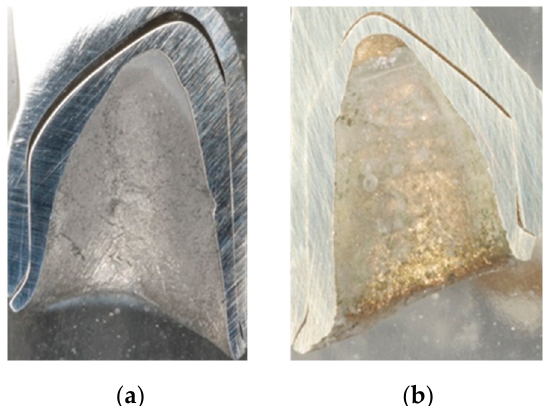
Figure 4. Overview images of microsections. ( a ) milled non-precious metal telescope; ( b ) cast Au telescope.